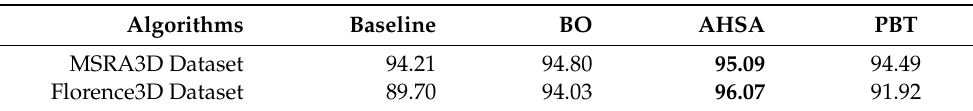
Table 4. Performance Comparison of SO-ConvESN optimized by three different HPO Algorithms based on Validation Accuracy